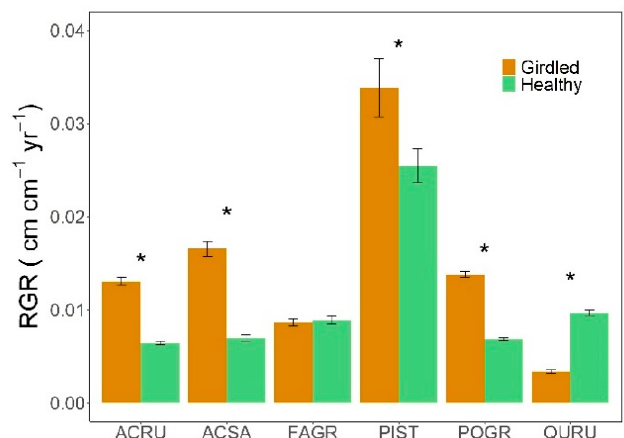
Figure 4. Experiment-wide mean girdled and healthy-tree relative growth rates (RGR, cm cm − 1 year − 1 ) of the six most abundant upper canopy ( > 8 cm DBH) tree species (Table 1) in the year following phloem-disrupting disturbance. Error bars are the SE of mean relative growth rate (RGR) among girdled or healthy trees of each species. Asterisks denote significance in the pairwise comparison of girdled and healthy trees of each species ( p < 0.05). Species abbreviations are: Acer rubrum (ACRU), A. saccharum (ACSA), Populus grandidentata (POGR), Fagus grandifolia (FAGR), Pinus strobus (PIST), Quercus rubra (QURU).